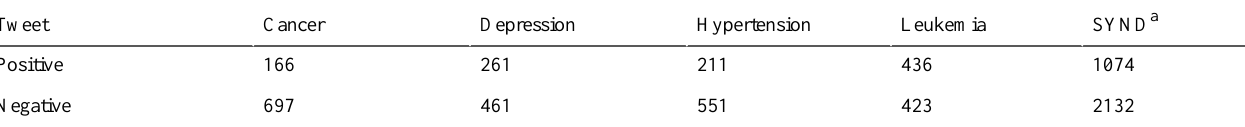
Table 2. The number of positive and negative tweets in the gold standard datasets.